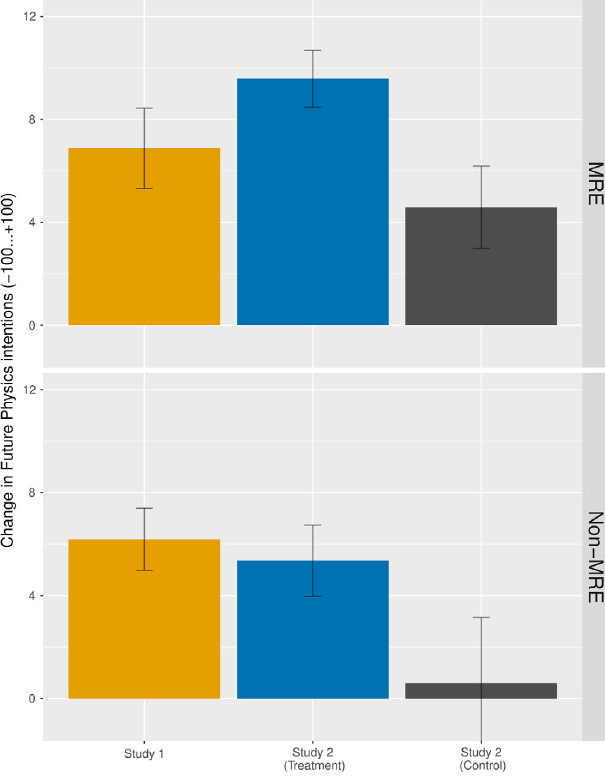
FIG. 2. Outcome of Study 1 (yellow-orange) and Study 2 (treatment in blue, control in gray). MRE-identified students (top panel) in Study 1, Study 2 treatment, and Study 2 control show statistically significant gains in future physics intentions; non- MRE-identified students (bottom panel) also show gains in Study 1 and in the Study 2 treatment. The difference between treatment and control is statistically significant for MRE ( p ¼ 0 . 008 ), but not for non-MRE students ( p ¼ 0 . 11 ). The height of each bar represents pre-post change in physics intentions (scale − 100 to þ 100 ); error bars represent standard